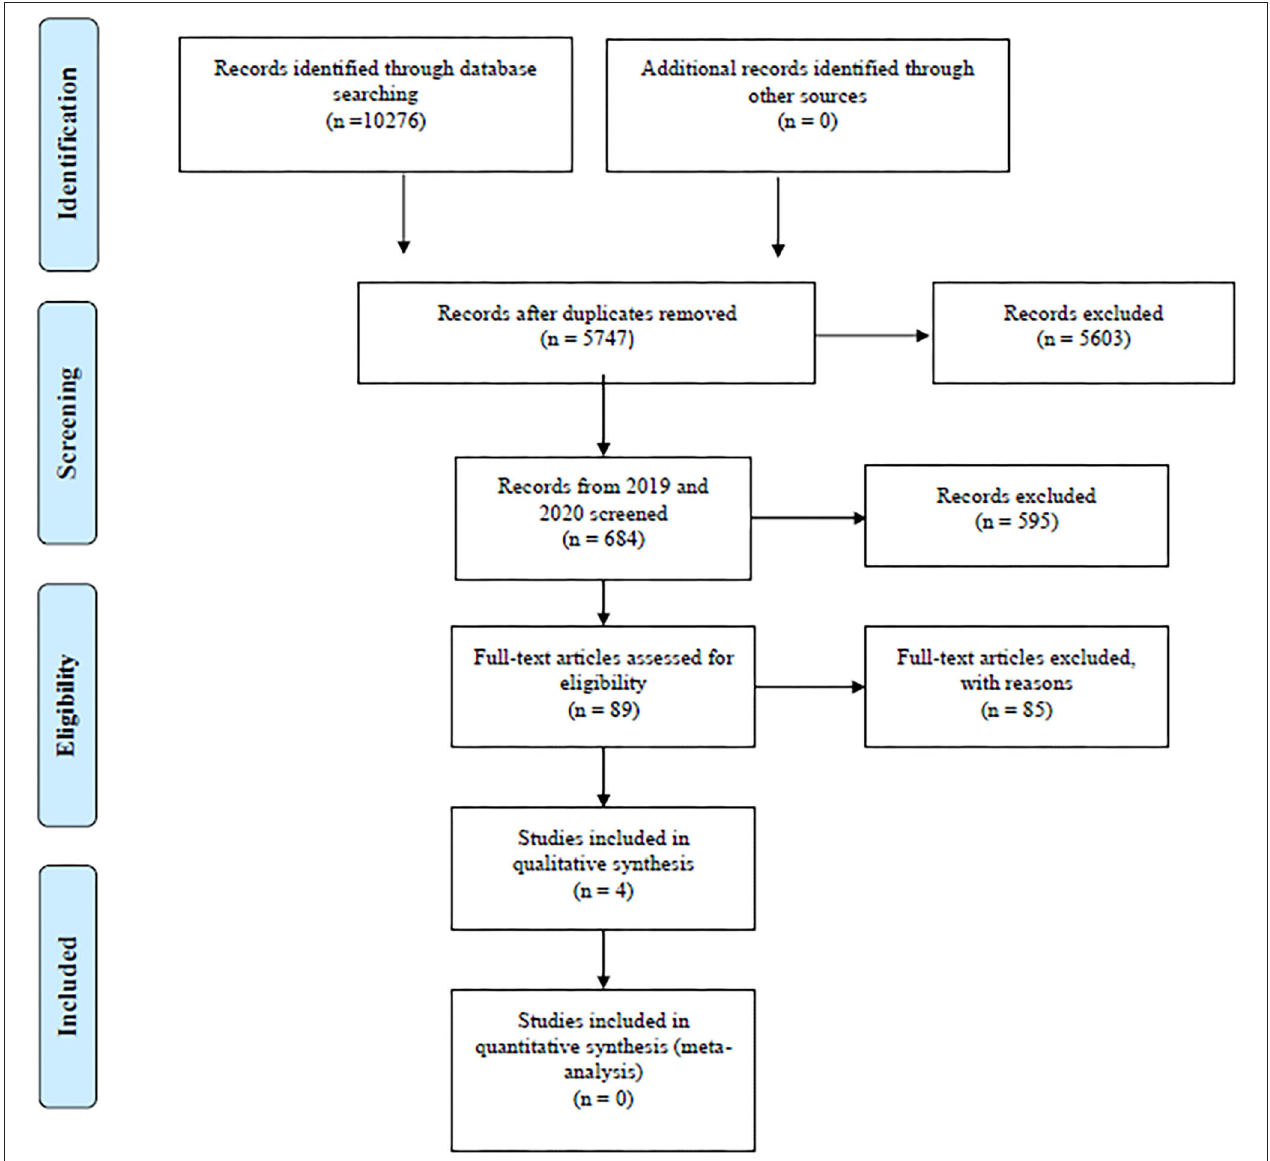
FIGURE 1 | PRISMA flow diagram. Overview of search and extraction process. From: Moher et al. (2009). For more information, visit www.prisma-statement.org.